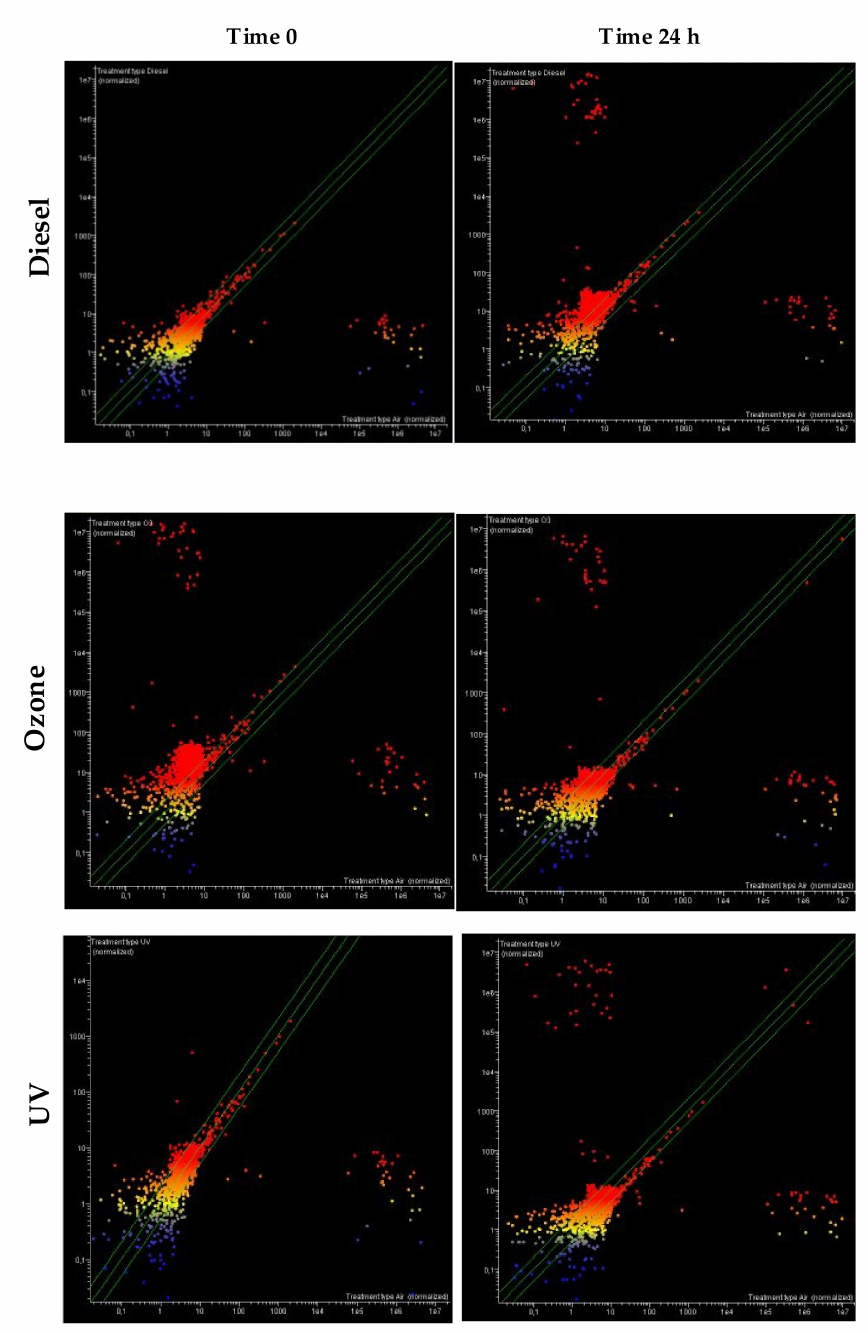
Figure 2. Scatter plot analysis of changes in miRNA-expression in human skin upon exposure to diesel, ozone, and UV at different times (0 and 24